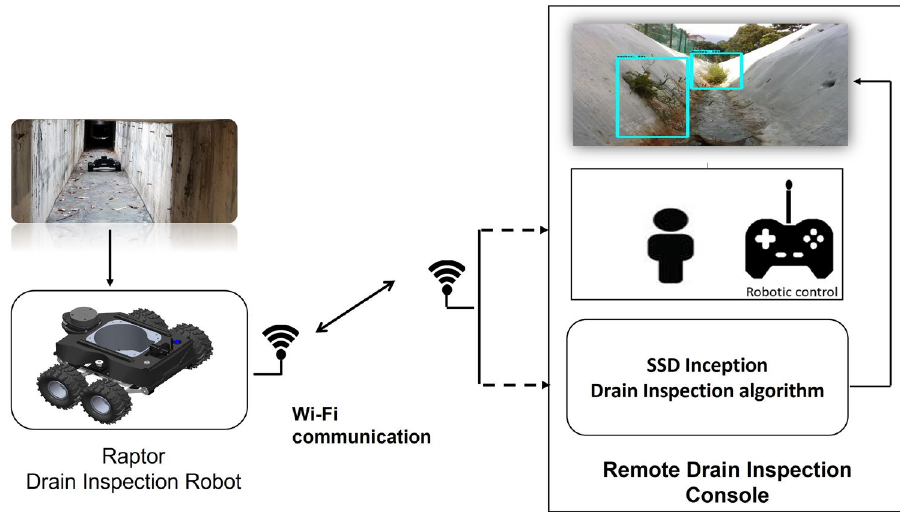
Figure 1. Overview of the drain inspection framework.